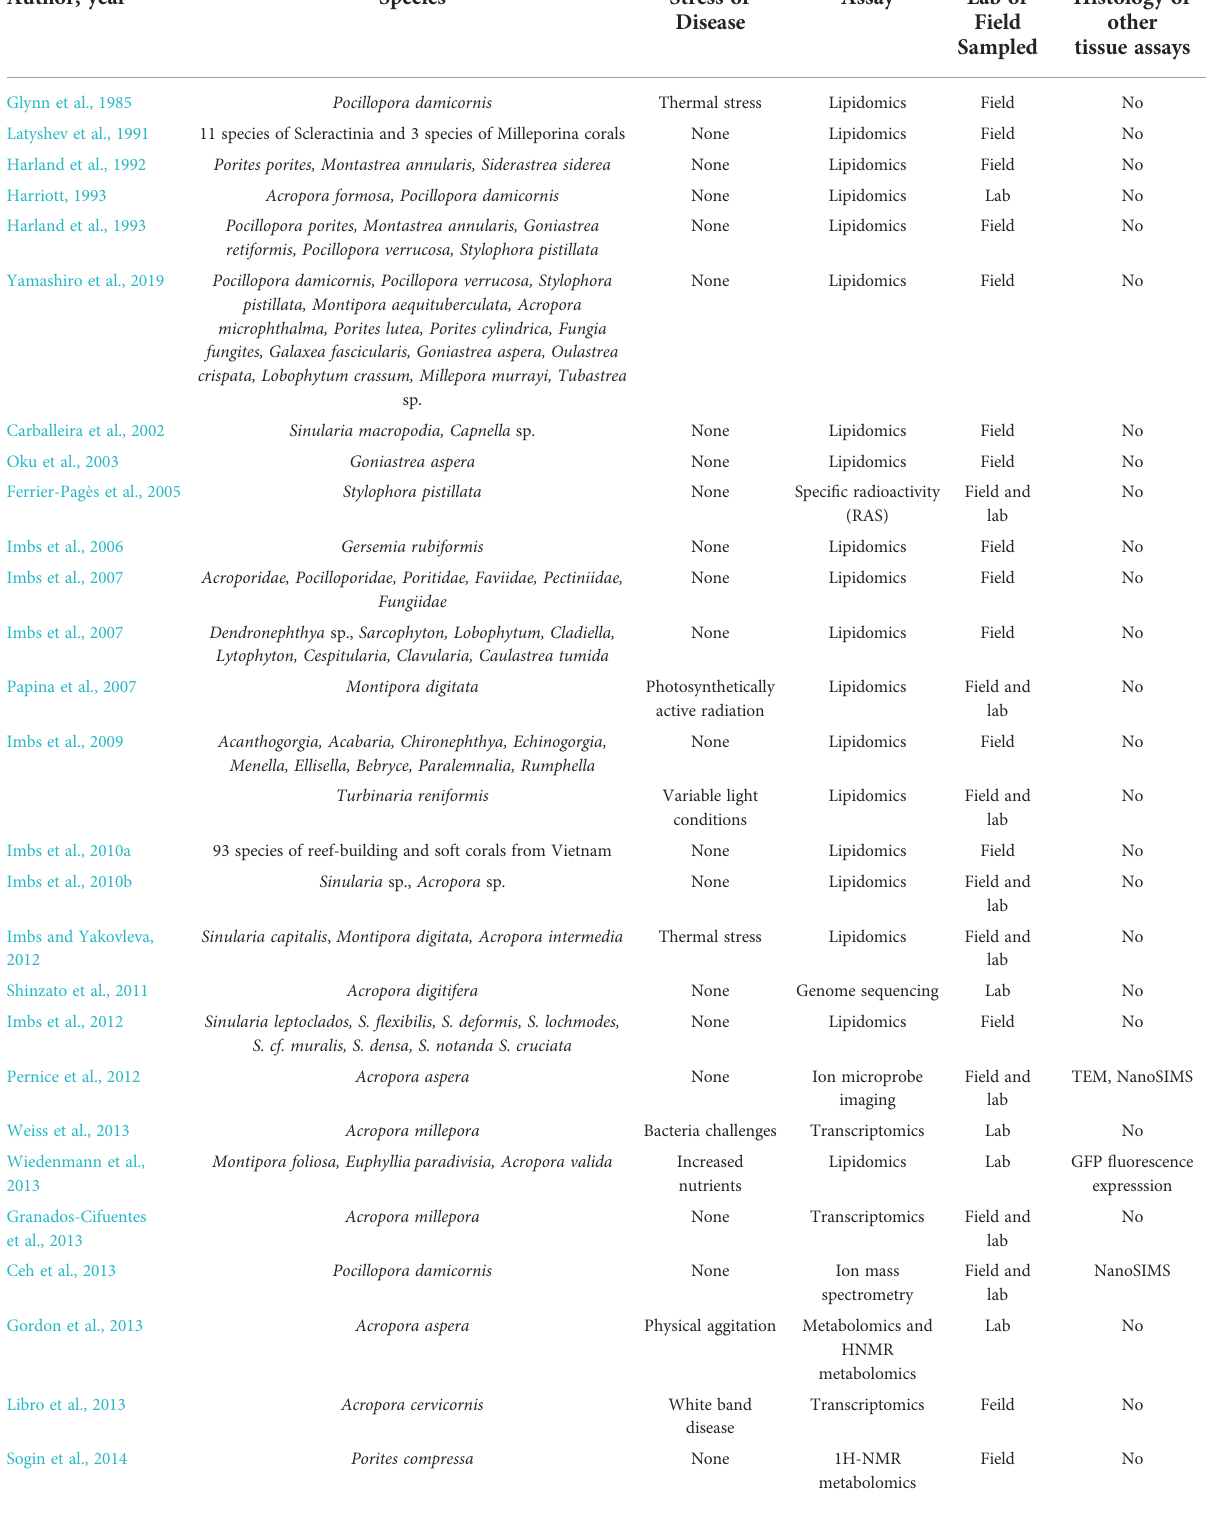
TABLE 1 Summary of previous 'omics studies done on soft corals, octocorals, and stony corals. Author,